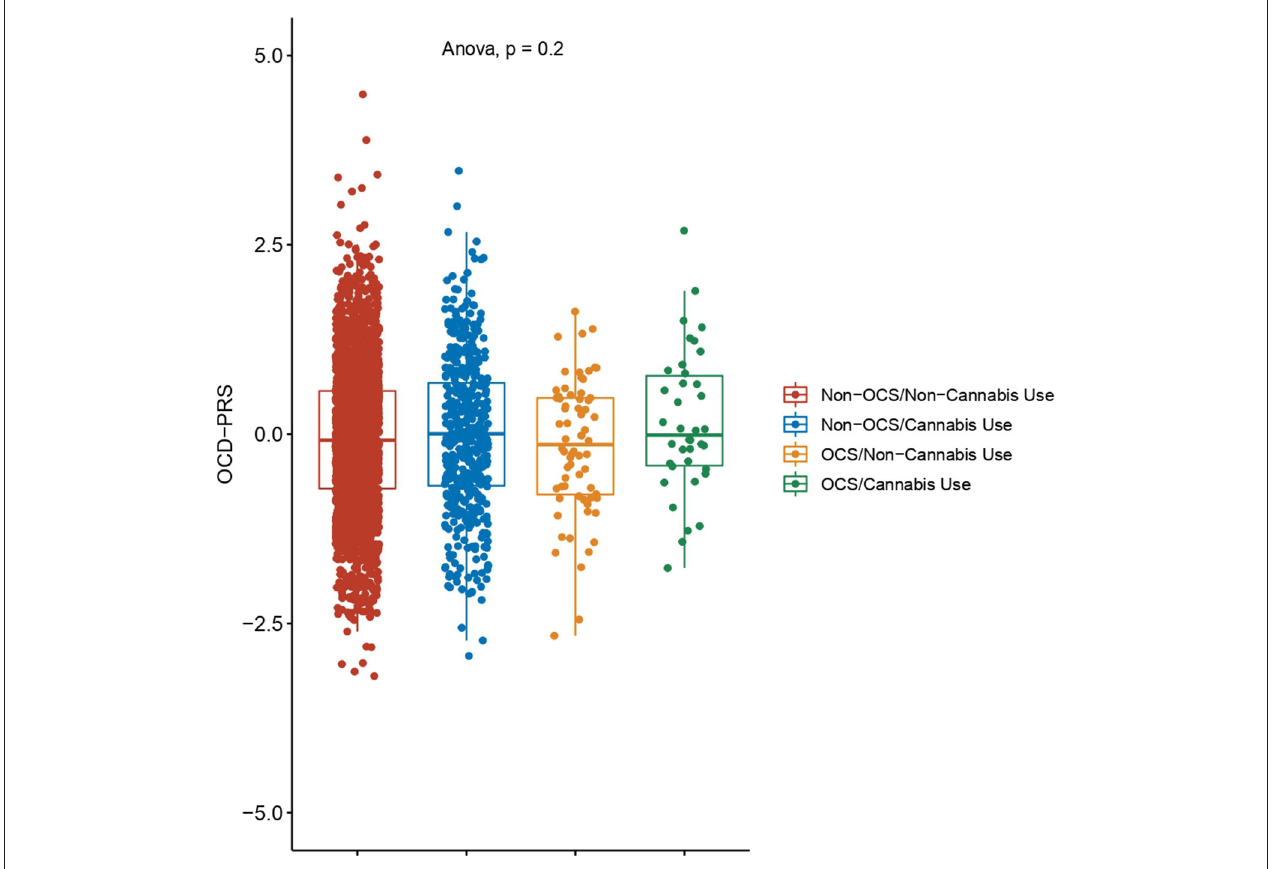
FIGURE 2 | Polygenic risk score for obsessive-compulsive disorder (OCD-PRS). The OCD-PRS was calculated with data reported by the Psychiatric Genomics Consortium and standardized by ancestry. Differences between the four groups were evaluated by ANOVA. Non-OCS: individuals without OCS